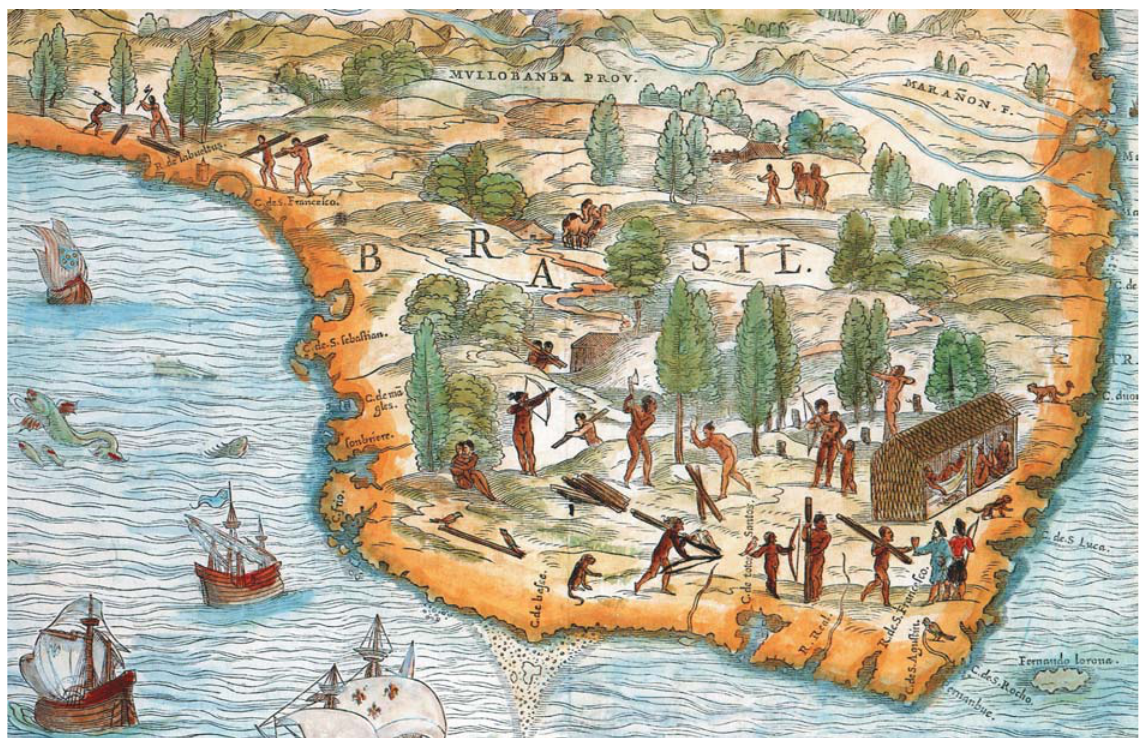
Fig. 6 – Detail of Map of Brasil made by Giácomo Gastaldi, 1550 (O Tesouro